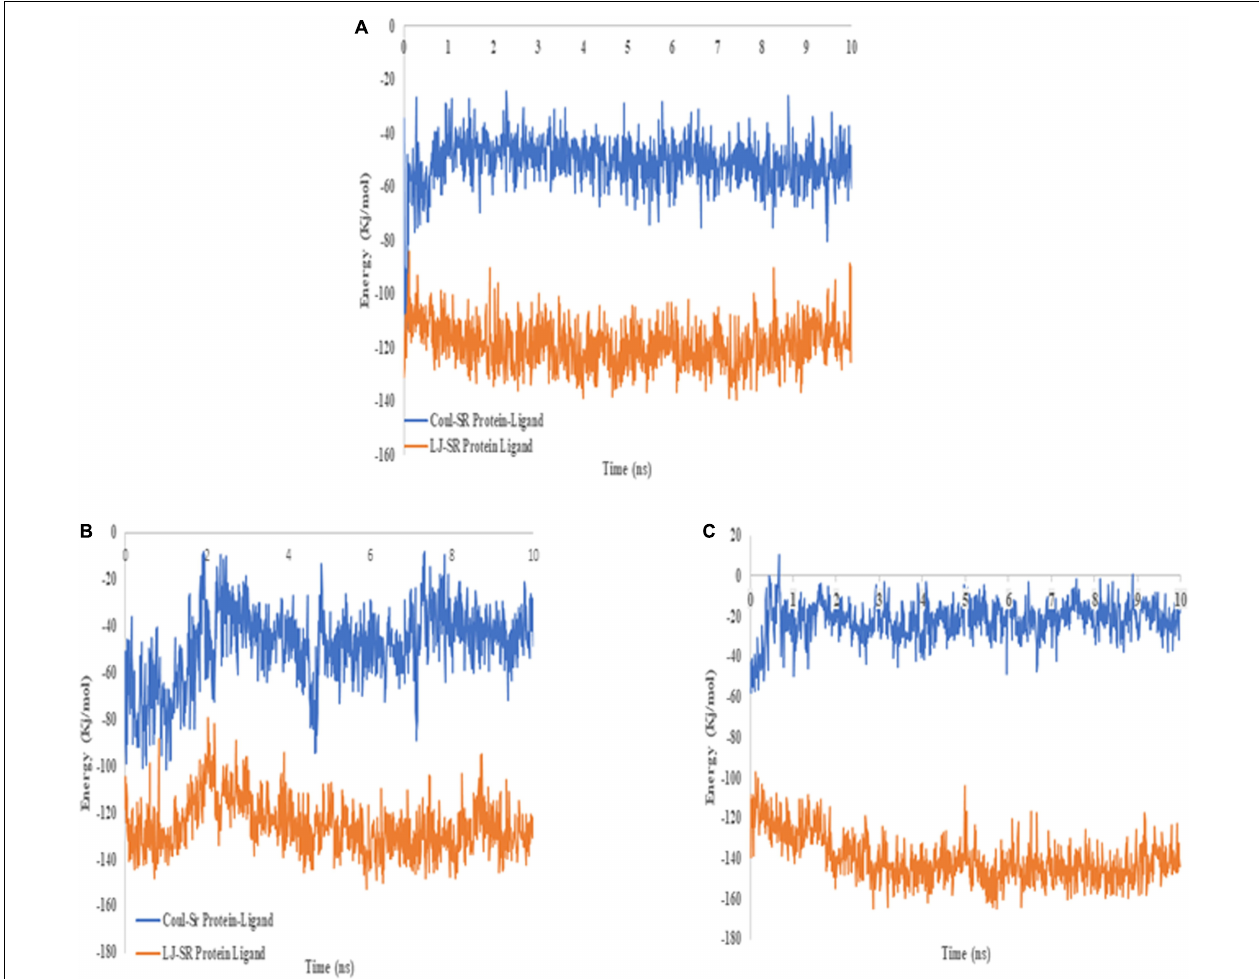
FIGURE 9 | 2D image of warfarin (blue) docked with CYP2C9 (A) wild type, (B) p.Arg144Cys , and (C) p.Ile359Leu. Hydrogen bonds are shown in orange, whereas eye-lashes are indicating hydrophobic